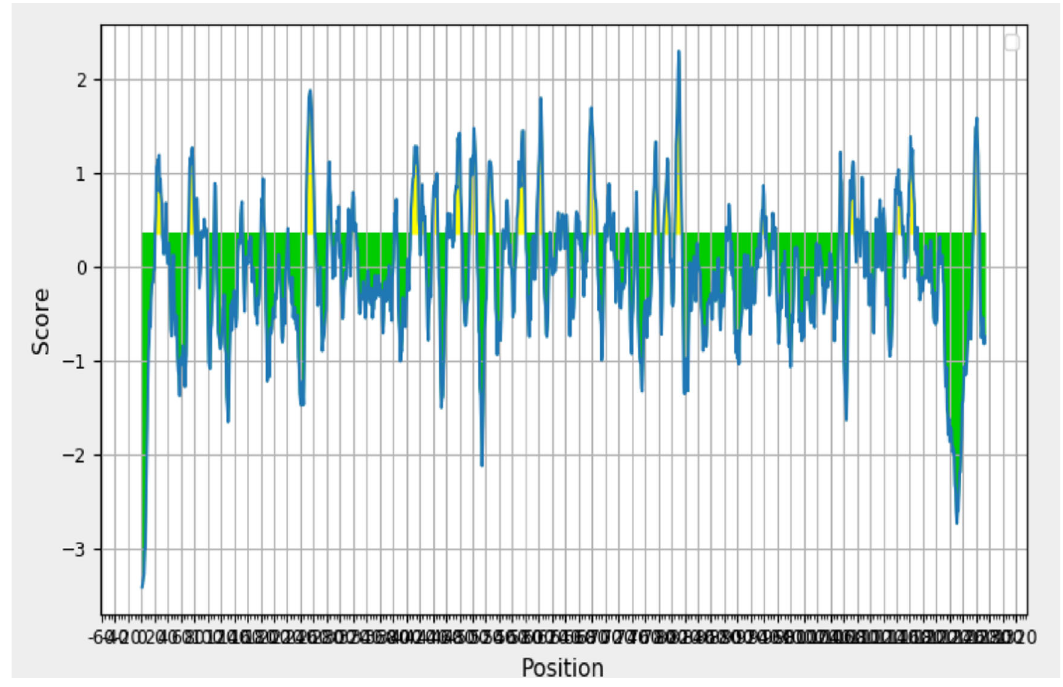
Figure 2. B-cell epitope prediction results on SARS-CoV-2 glycoprotein spike using BepiPred method. Regions with positive predictions are highlighted in yellow and green for negative predictions.